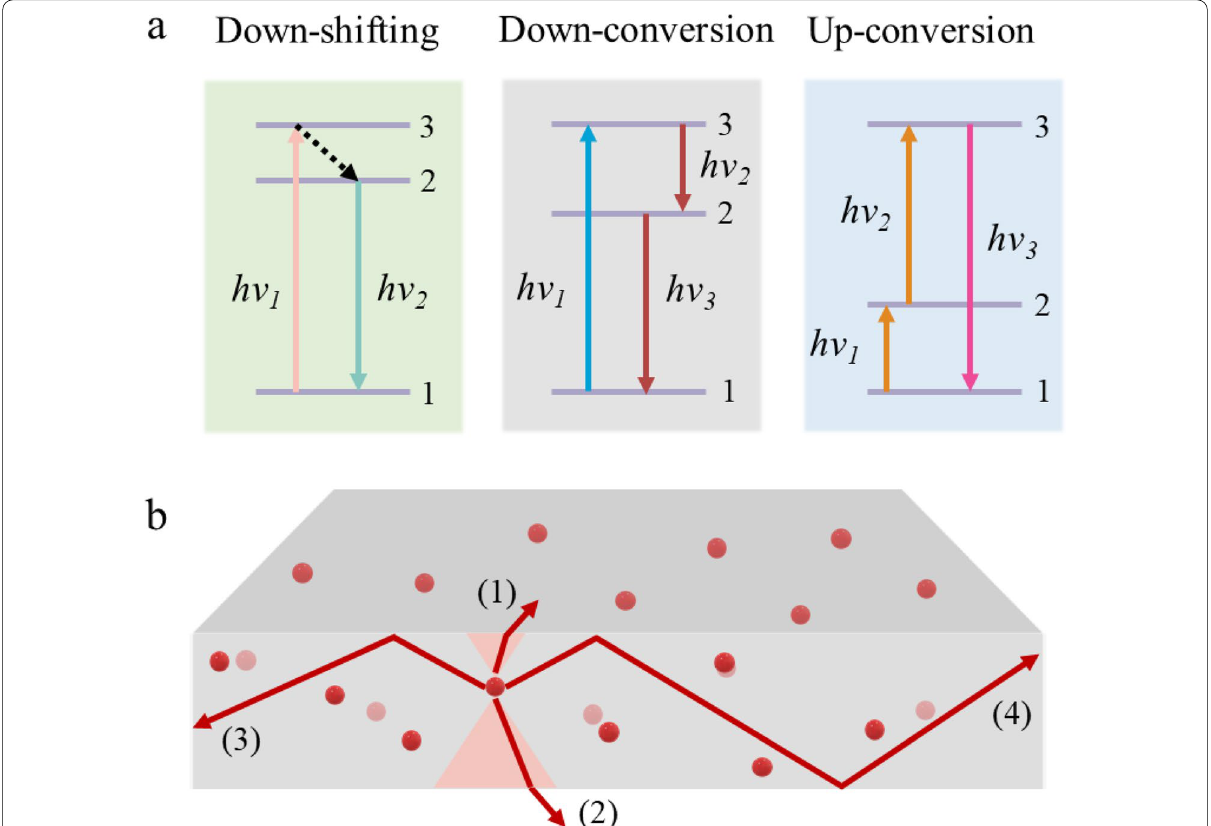
Fig. 2 a Three photoluminescence processes employed in spectral converters and b Schematic illustration of the spectral conversion material with flat designs. The re-emitted photons in the spectral conversion materials either escape from the light escape cone (rays 1 and 2) or are trapped in the materials (rays 3 and 4) due to total internal